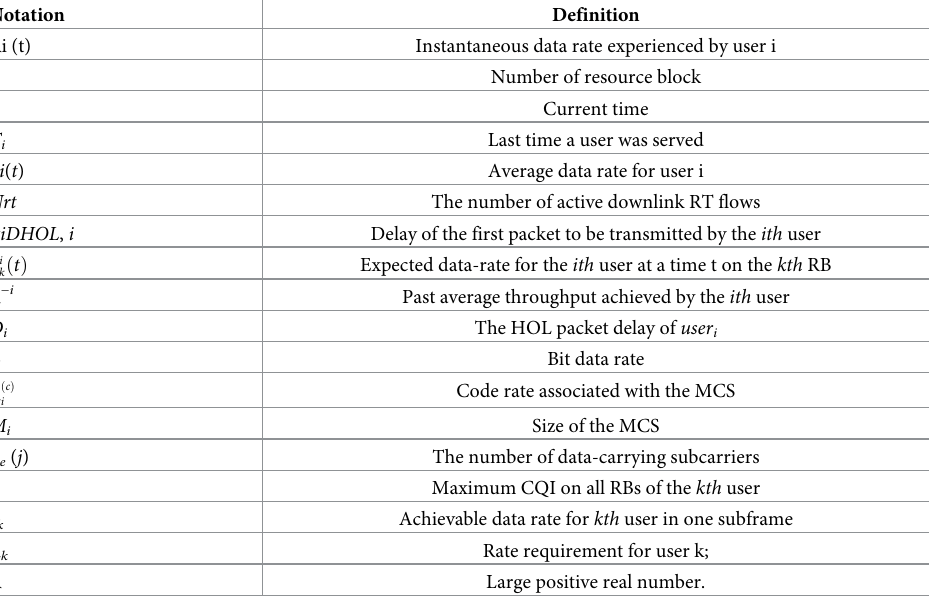
Table 1. Some notations used in this